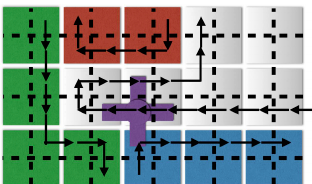
Figure 13: Each pixel is divided into 4 sub-pixels. The arrows show steps of Pavlidis’ algorithm. Only the blue pixel is neighbor of the sub-pixel that is marked with a cross. The cross touches all neigbors of a 4-neighborhood of sub-pixels.